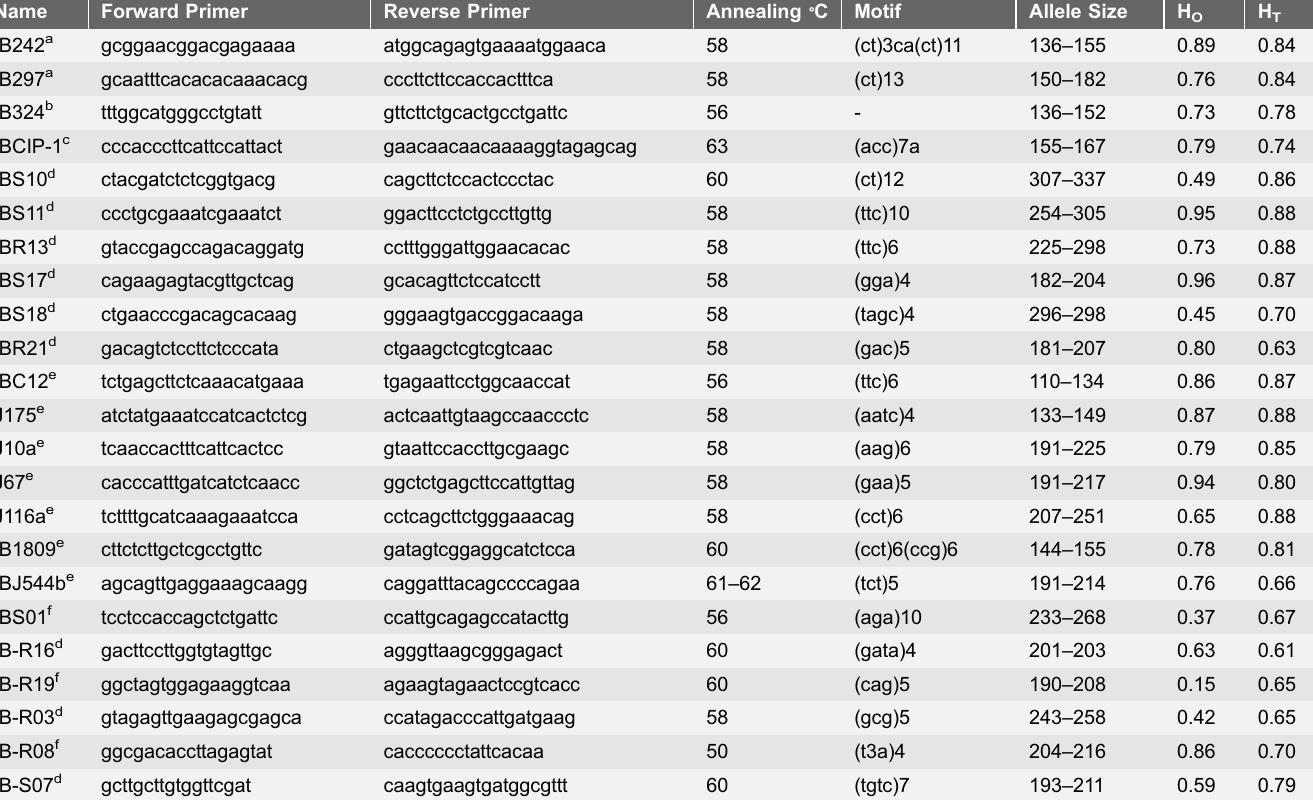
Table 1. Twenty-three SSR marker primers with their respective sequence, annealing temperatures, repeat motifs and allele